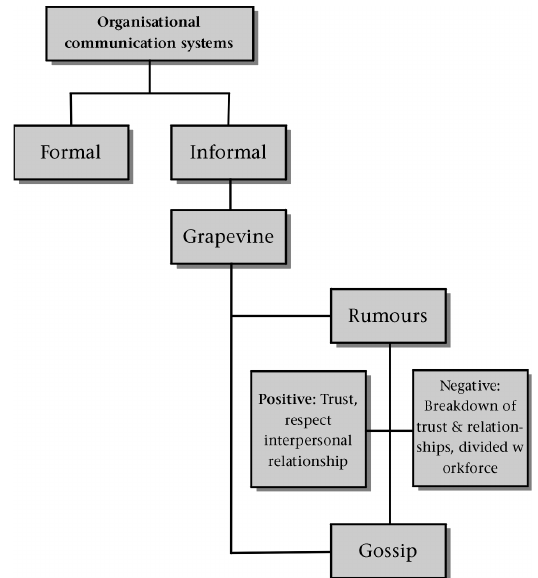
Figure 1: A Pattern of Informal Organisational Communication